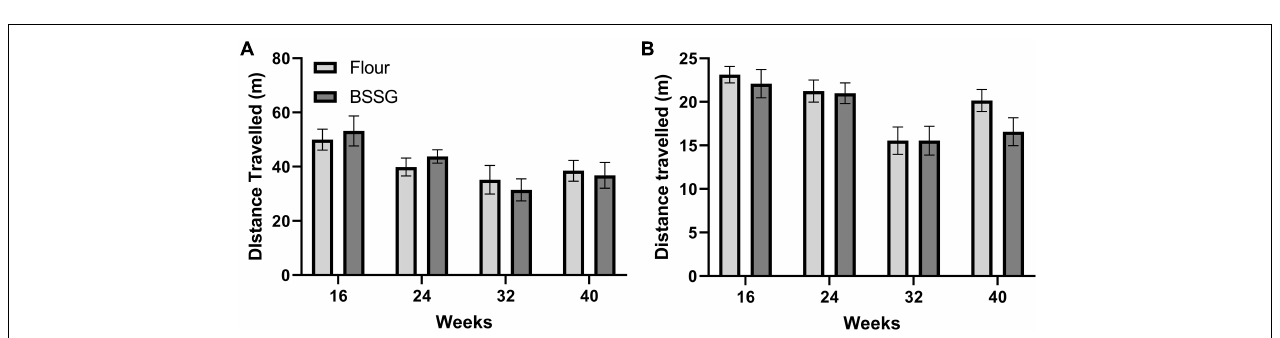
FIGURE 4 | Distance travelled in the open field. (A) 60 min duration and (B) first 10 min within the open field arena. There were no group differences in distance travelled at any of the assessment points. Data are shown as means ± SEM, n = 8–10.